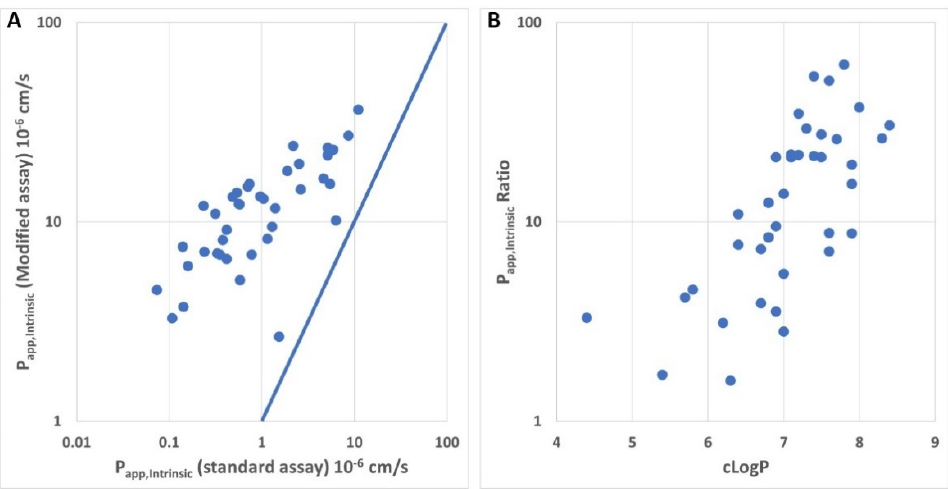
Figure 4. Comparison between the apparent permeability measured with the standard and the modified MDCK-MDR1 assay for a chemical series (N = 39). The standard permeability assay was performed as described in Section 2.3. The modified permeability assay with prolonged preincubation time is described above. All P app values represent mean values of duplicates. P app,Intrinsic ratio is calculated by dividing P app,Intrinsic from the modified assay by P app,Intrinsic from the standard assay. ( A ) P app,Intrinsic values from the modified assay were plotted against P app,Intrinsic values from the standard assay. Solid line shows 1:1 correlation. ( B ) Ratios between P app,Intrinsic values from standard and modified assays were plotted against cLogP.